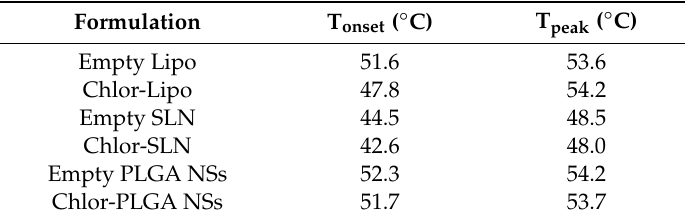
Table 2. DSC analysis of empty and Chlor-loaded nanocarriers.